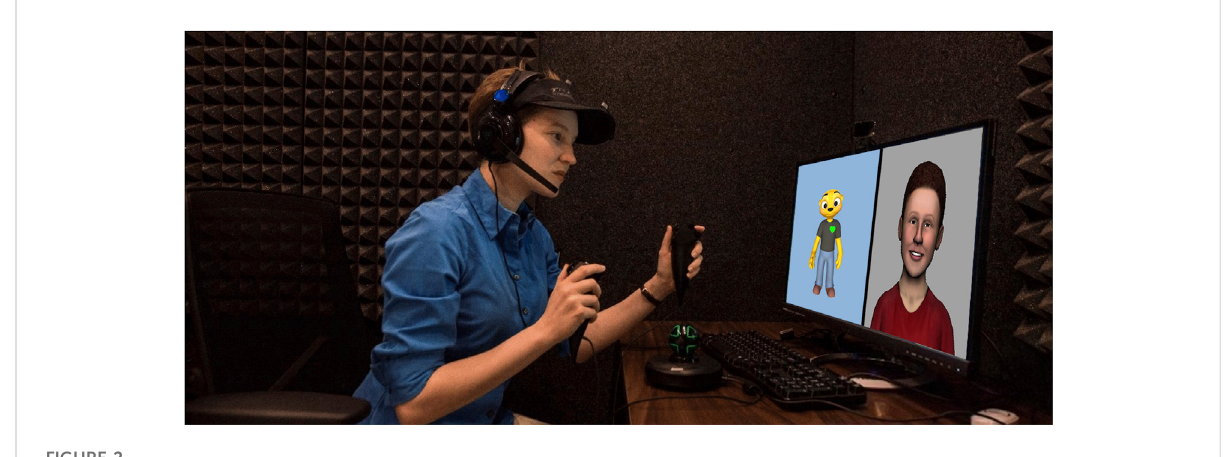
FIGURE 2 Interactor at work puppeteering Zoobee and viewing